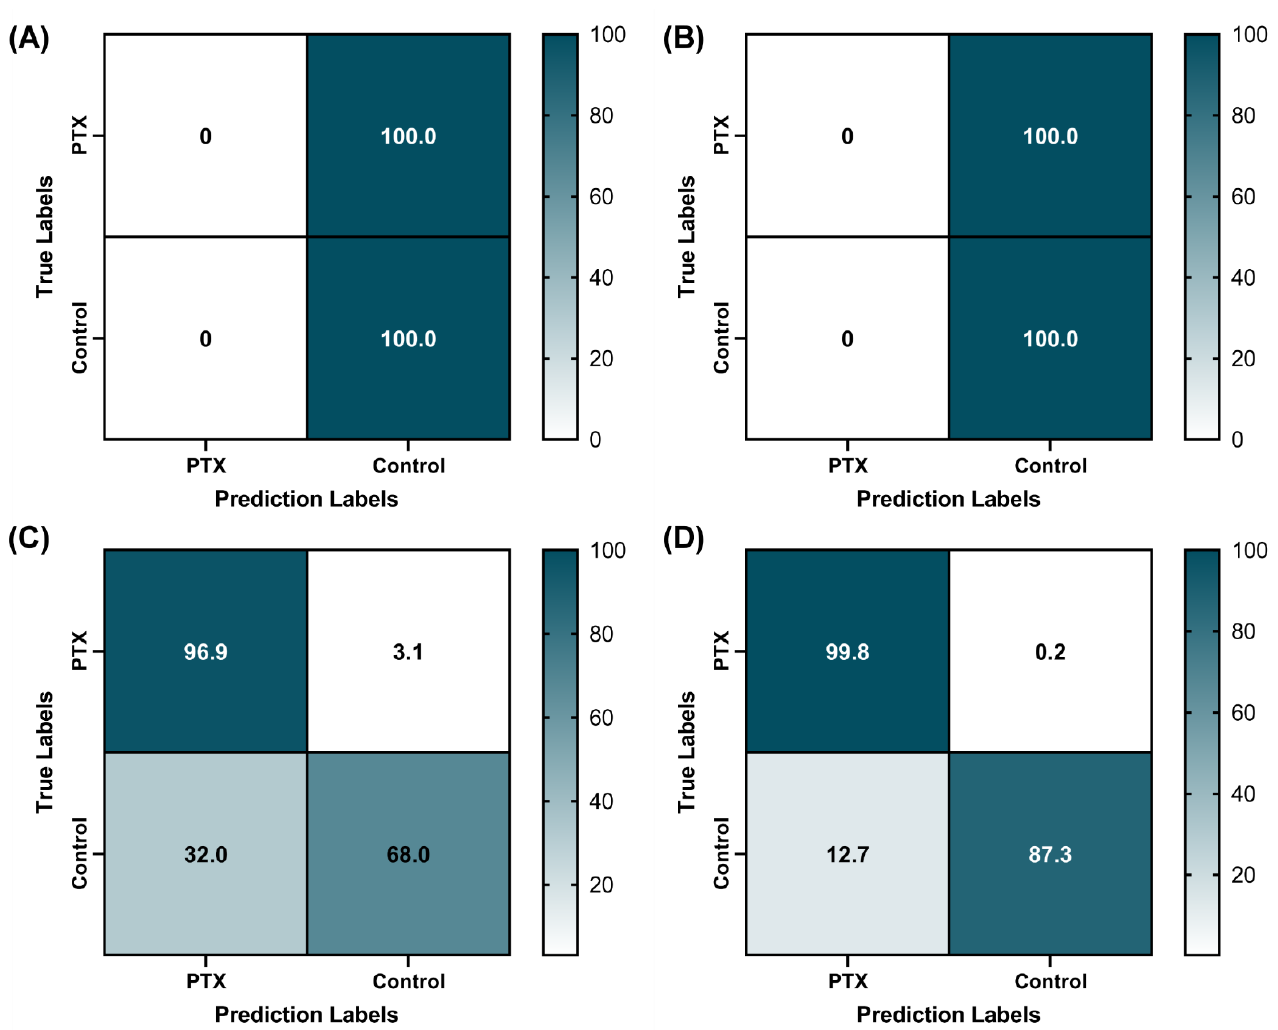
Figure 5. Confusion matrix results for swine image predictions using four image augmentation approaches. Average confusion matrix results are shown for ( A ) no image augmentation ( n = 3 independent trained models), ( B ) using zoom and flip image augmentation ( n = 3 trained models), ( C ) further including image histogram swine/phantom matching ( n = 5 trained models), and ( D ) finally including contrast and brightness image augmentation ( n = 5 trained models). All models were trained on processed M-mode segments collected in the synthetic phantom apparatus, and confusion matrix test results are shown for swine M-mode image sets ( n = 400 total image segments, equal number of positive and negative PTX images). Results are shown as mean percent across replicate trained models for each confusion matrix category.